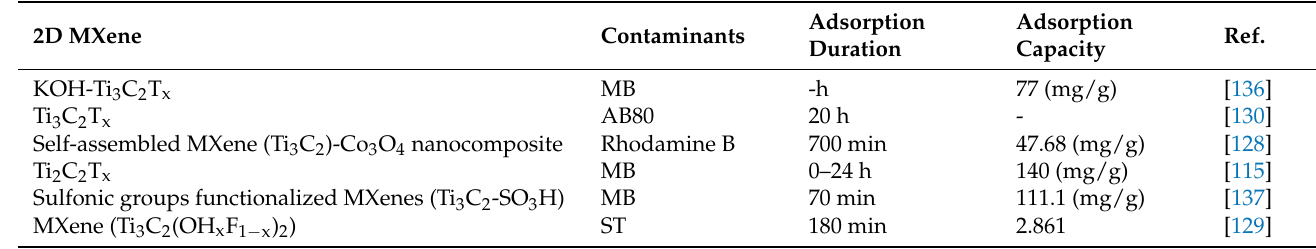
Table 3. Utilizing of MXenes for dye removal.